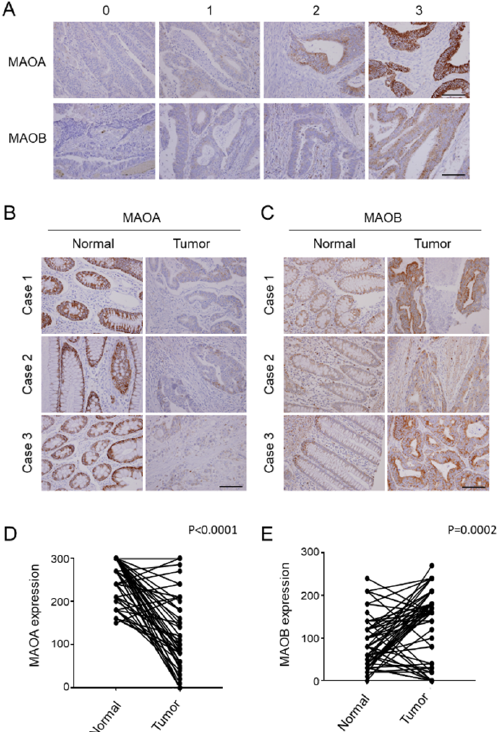
Figure 3. Immunohistochemical (IHC) results of monoamine oxidase A (MAOA) and MAOB expressions in a Taiwanese colorectal cancer cohort. ( A ) Representative pictures of expressions of MAOA and MAOB by IHC staining. An intensity score of 0 was defined as negative cytoplasmic staining, of 1 was defined as weak cytoplasmic staining, of 2 was defined as moderate cytoplasmic staining, and of 3 was defined as strong cytoplasmic staining. Scale bar indicated 100 μ m. ( B ) Representative IHC staining images for MAOA and MAOB levels in paired normal (N) and tumor tissues (T) from selected colorectal cancer patients. The magnifying factor used in these representative pictures is ×400, and the intensity score of MAOA in the N part was 3. Scale bar indicated 100 μ m. ( C ) Quantified results of cytoplasmic levels of MAOA and MAOB from IHC staining in primary colorectal cancer and corresponding normal colon mucosa. A total of 59 N/T paired data were included. The scores were calculated as the staining intensity score × percentage of stained cells.